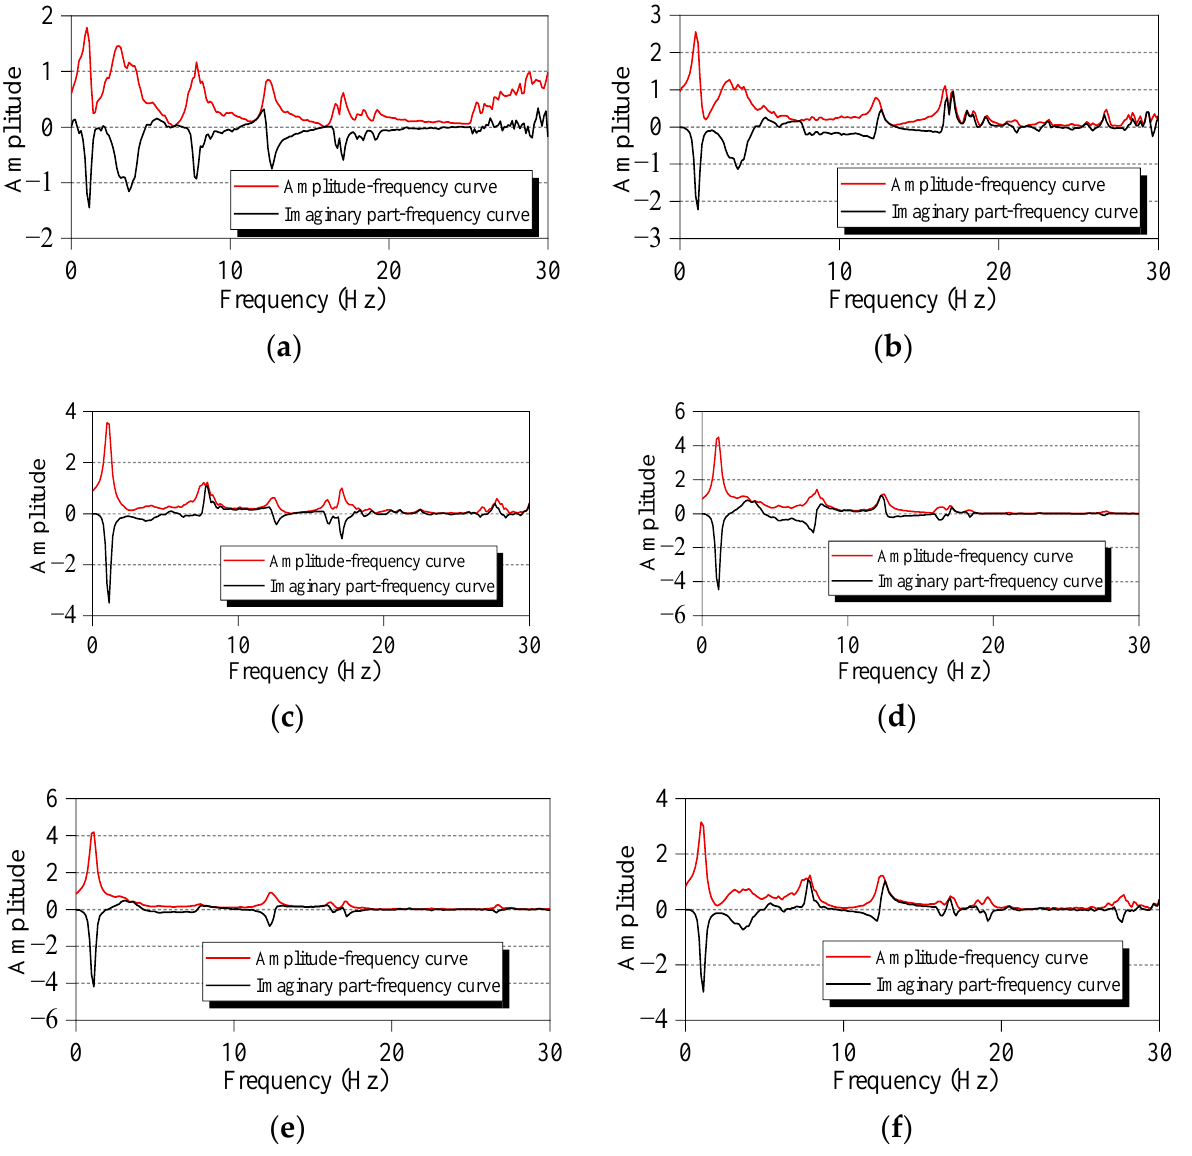
be seen from the data in the table that the arrangement of NLVDs enhanced the damping ratio of the first three modes of the isolated structure.